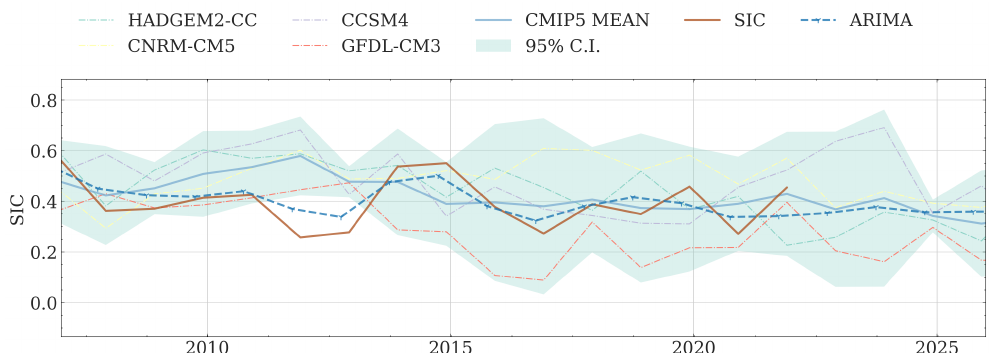
Figure 21. October, November, and December mean SICs from ERA5, CMIP5, and the ARIMA model in sub-region no.